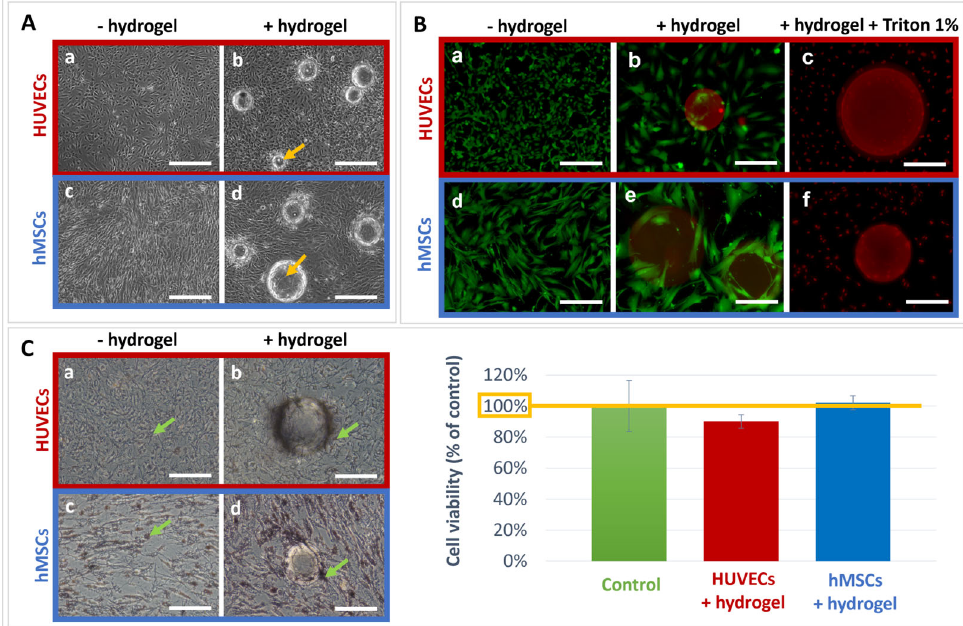
Figure 5. Cell viability. ( A ) Representative images of HUVECs and hMSCs cells cultured without (a,c) or with (b,d) the hydrogel microspheres (yellow arrows) for 72 h under phase-contrast microscopy. Scale bar = 400 µ m. ( B ) Representative images of the HUVECs and hMSCs cells labelled with fluorescent Live/Dead ® staining (living cells in green; dead cells in red) after culture without (a,d), or with the microspheres (b,e) and the positive control where the cells were incubated with Triton™ 1% (c,f). (a,d) Scale bar = 400 µ m; (b,c,e,f) scale bar = 200 µ m. ( C ) Representative images of HUVECs and hMSCs cultured with the hydrogel microspheres for 72 h under phase-contrast microscopy (a–d) with visible MTT crystals (green arrows). Scale bar = 200 µ m. Cell viability quantification showed no effect of the hydrogel on HUVECs or hMSCs viability. The results are expressed as percentage of control (culture media without hydrogel).